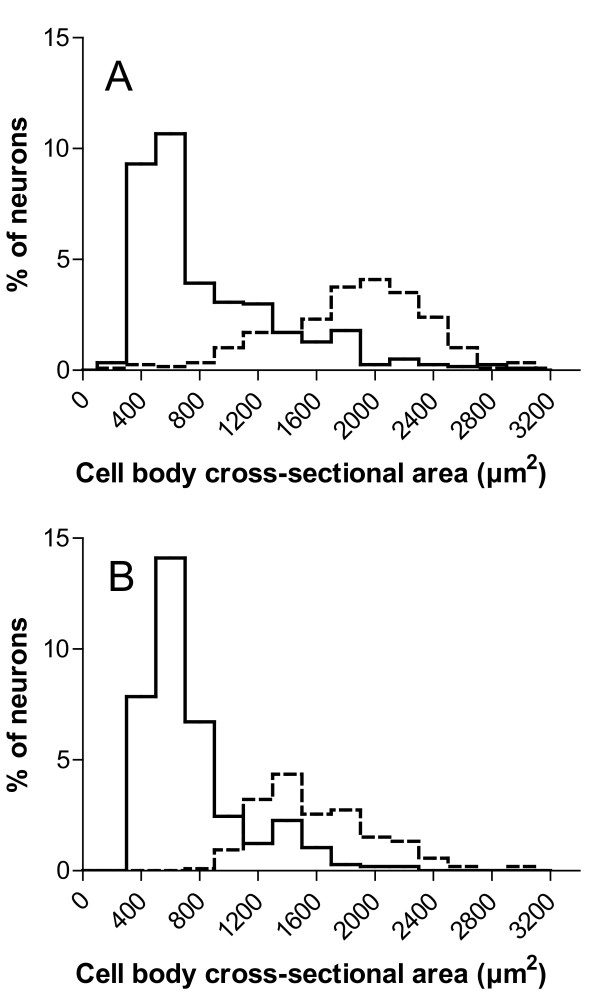
Cell body size frequency histograms of neuronal cell bodies with strong expression for ATP7A (solid lines) and CTR1 (dotted lines) in DRG tissue. ATP7A and CTR1 were strongly expressed distinctly by the small neurons and large DRG neurons, respectively, from control (A) and oxaliplatin-treated animals (B). Oxaliplatin caused a left-ward shift in the size profile of strongly CTR1-immunoreactive neurons but not that of strongly ATP7A-immunoreactive neurons. Each bin represents the mean value of 5 animals.